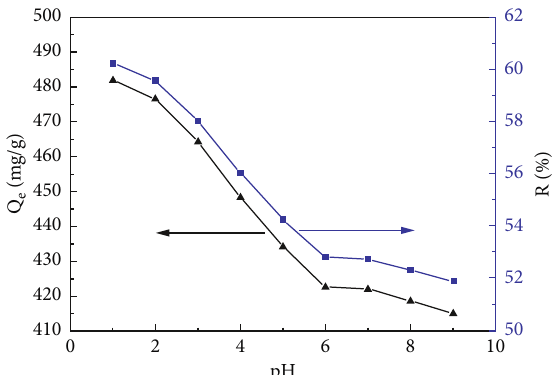
Figure 10: Effect of pH on the removal of Cr(VI) by the PPy/Fe